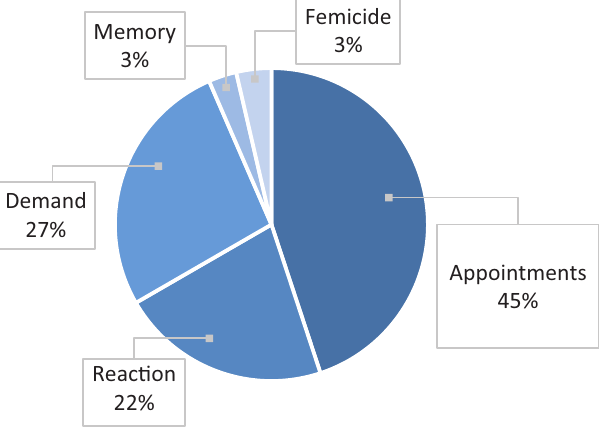
Figure 2. Themes of Twitter counter‐trends.